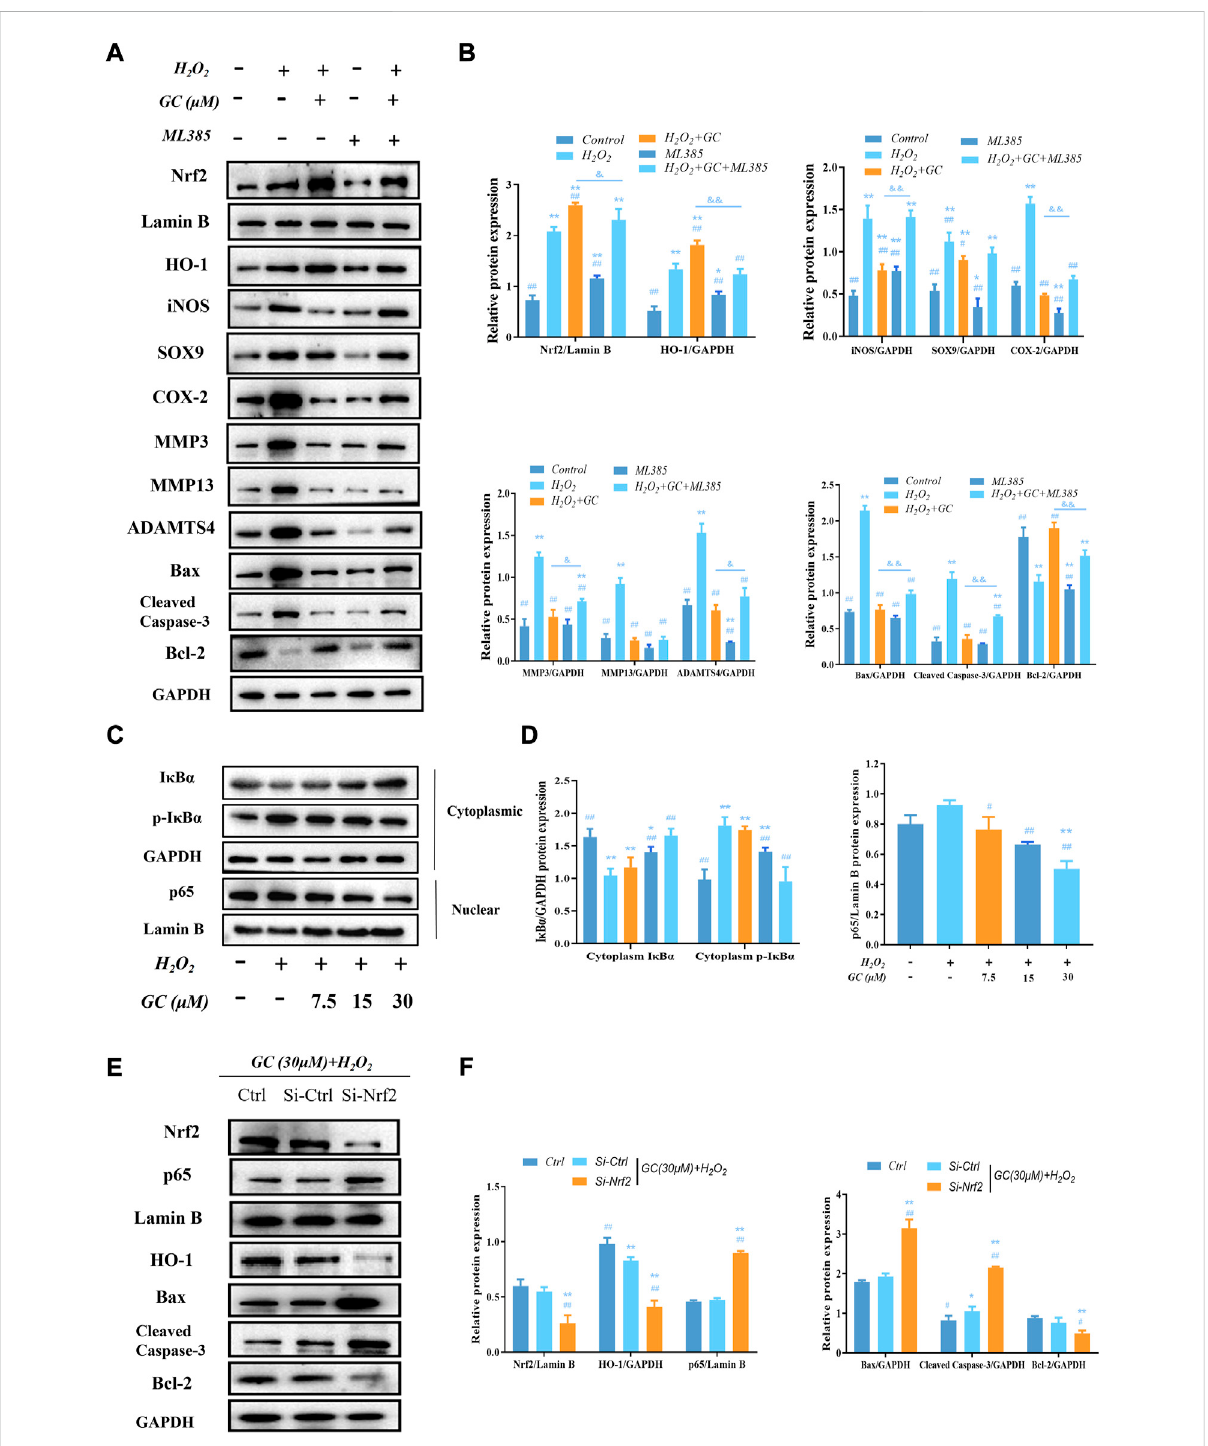
FIGURE 4 GC exerts protective effect on H 2 O 2 -induced chondrocytes through Nrf2/HO-1 and NF- κ B pathways. (A and B) Western blot images and quanti fi cation data of Nrf2, HO-1, iNOS, SOX9, COX-2, MMP3, MMP13, ADAMTS4, Bcl-2,Bax, and Cleved-caspase three for eachgroup treatedwith 30 μ M GC, H 2 O 2 , and 10 μ M ML385. (C and D) Western blot image and quanti fi cation data for cytoplasm I κ B α , p-I κ B α , and nuclear p65 protein expression for each group treated with GC and H 2 O 2 . (E and F) After transfection with Nrf2 siRNA, the protein expression levels of Nrf2 and p65 in the nucleus and HO-1, Bax, Cleved-caspase 3, and Bcl-2 in the cytoplasmicof chondrocytes co-applied with GC and H 2 O 2 were analyzed by westernblot.Alldataarepresentedasmean±SD(n=3).** p < 0.01 vs. controlgroup; ## p < 0.01 vs. H 2 O 2 group; ＆ p < 0.05and ＆＆ p < 0.01 vs. H 2 O 2 + GC